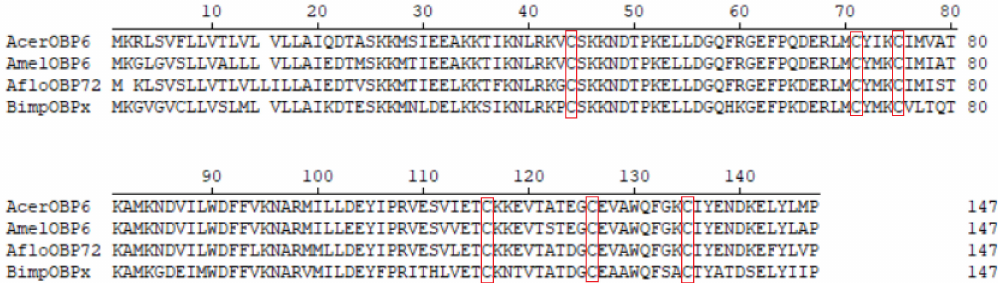
Figure 1. Amino acid sequence alignments of AcerOBP6 with other homologous proteins. Acer, Apis cerana cerana ; Amel, Apis mellifera ; Aflo, Apis florea ; Bimp, Bombus impatiens . Six conserved cysteines are boxed with the red